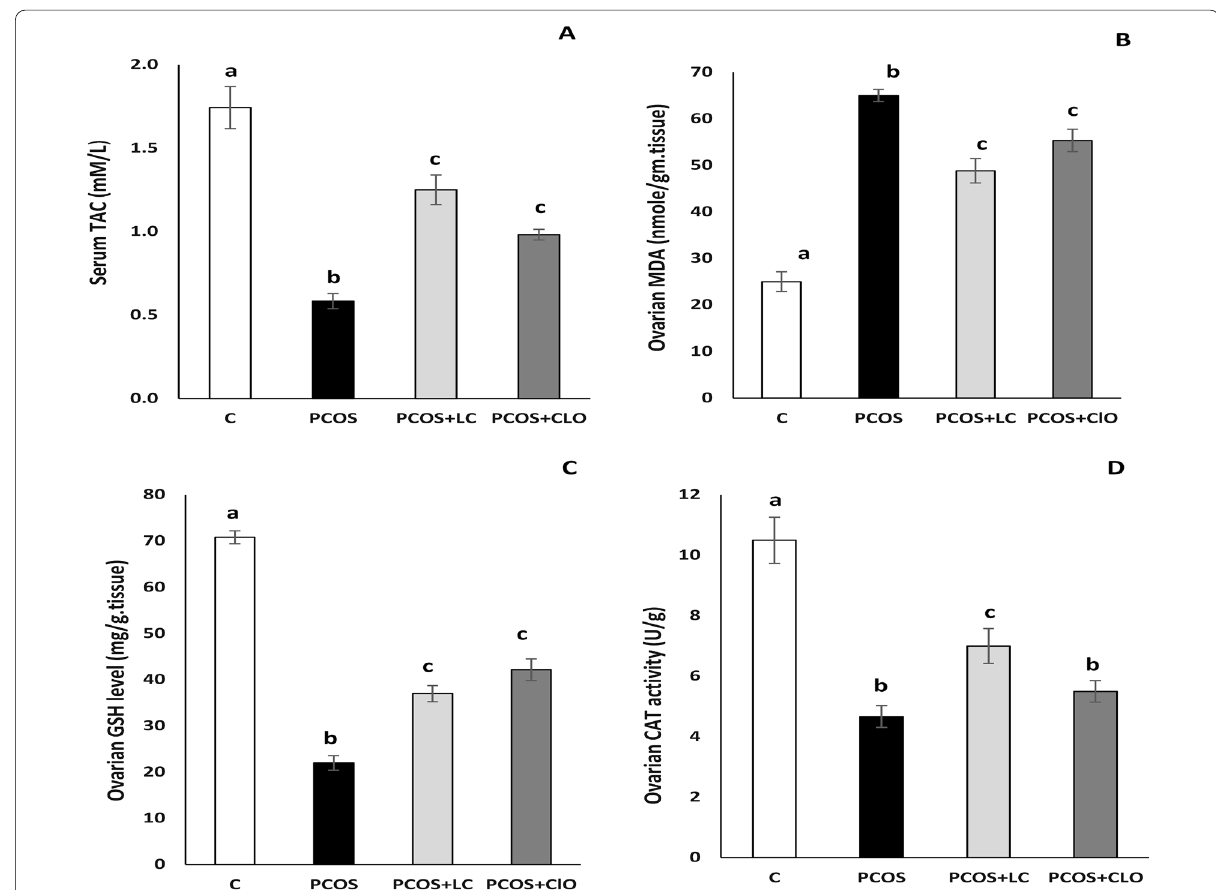
Fig. 2 Effect of l -Carnitine and Clomiphene citrate on Levels of MDA, GSH and CAT in ovarian tissues and serum TAC in letrozole-induced PCOS rat model. Values presented as mean SE ( n 6). Means denoted with different superscript letters are statistically significant at P < 0.05. A TAC: ± = Total antioxidant capacity, B MDA: Malondialdehyde, C GSH: Glutathione reduced and D CAT: Catalase. C: Control group, PCOS: letrozole induced polycystic ovarian syndrome, PCOS LC: letrozole induced polycystic ovarian syndrome treated with l -Carnitine, PCOS + polycystic ovarian syndrome treated with Clomiphene